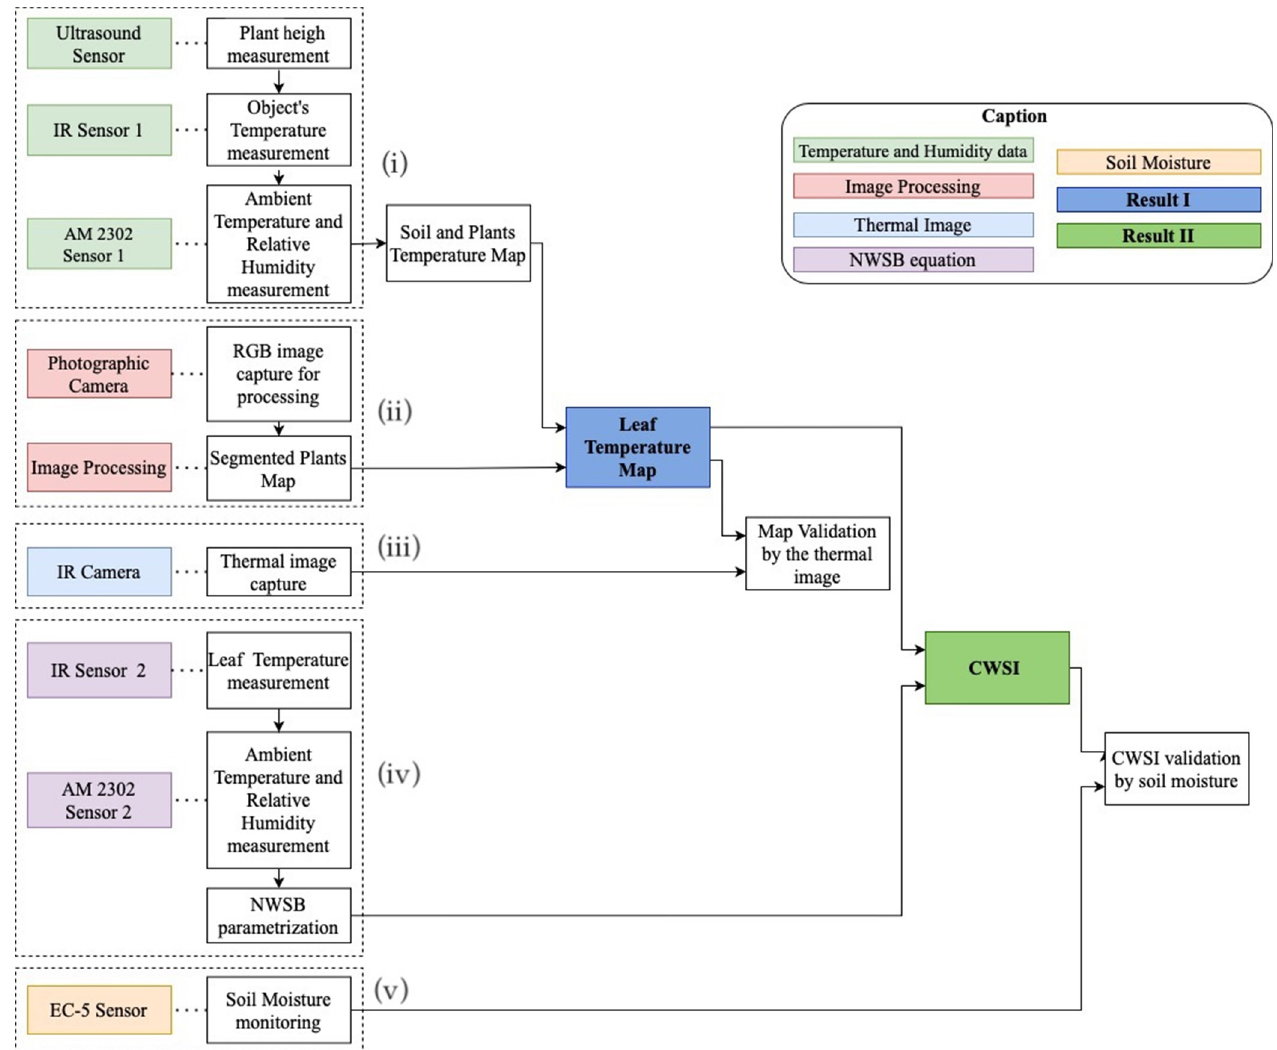
Figure 1. Steps of the methodology adopted for detection of water stress through the CWSI.